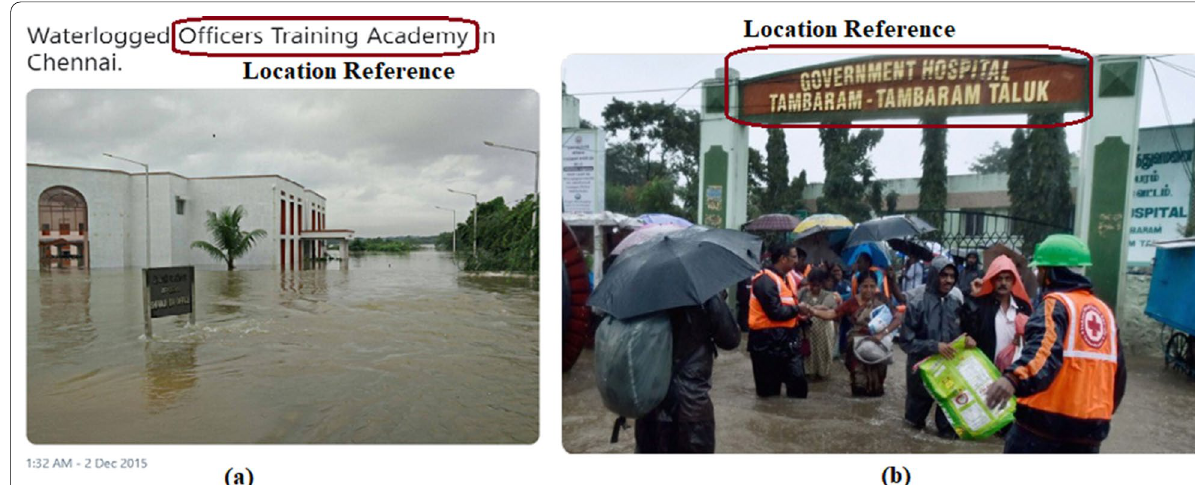
Fig. 4 Sample images in social media with reference to location and water